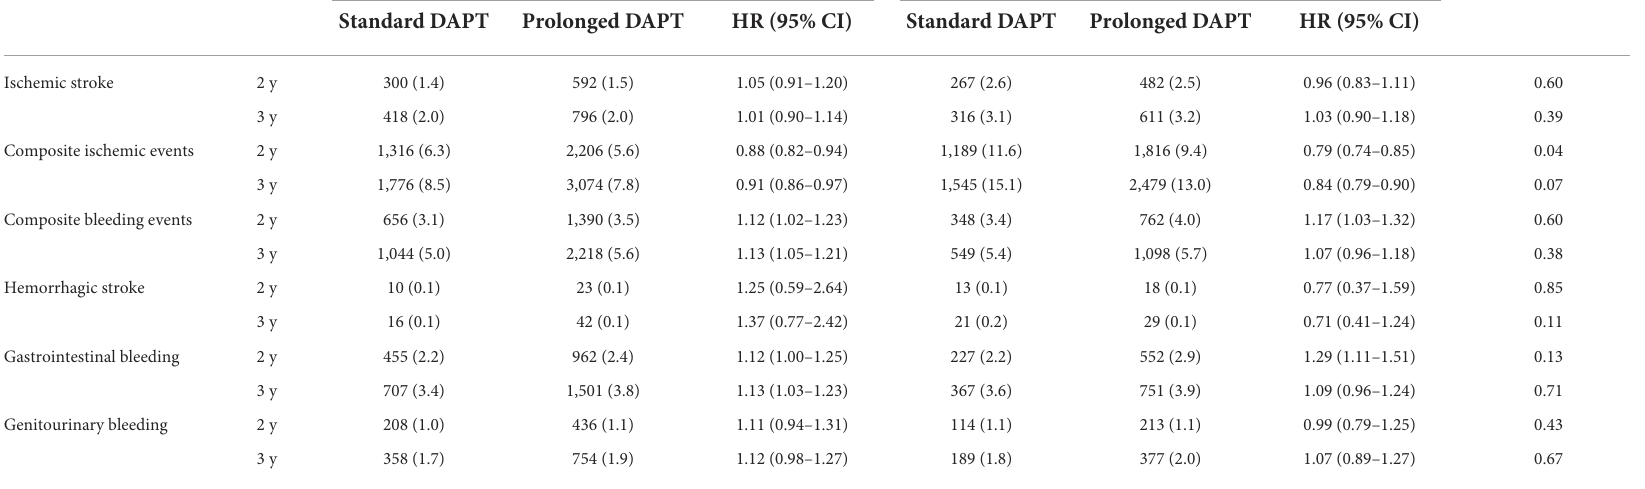
Numbers in parentheses represent the percentage. y indicates year. The hazard ratio (HR) and p value for interaction were calculated by Cox proportional hazard model. CI, confidence interval; DAPT, dual antiplatelet therapy; DM, diabetes mellitus; IPTW,inverseprobabilityoftreatmentweighting. a Compositeofcardiovasculardeath,myocardialinfarction,andischemicstroke. b